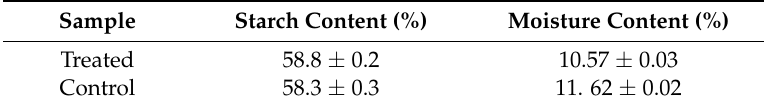
Table 2. Moisture and starch content of barley grains before and after